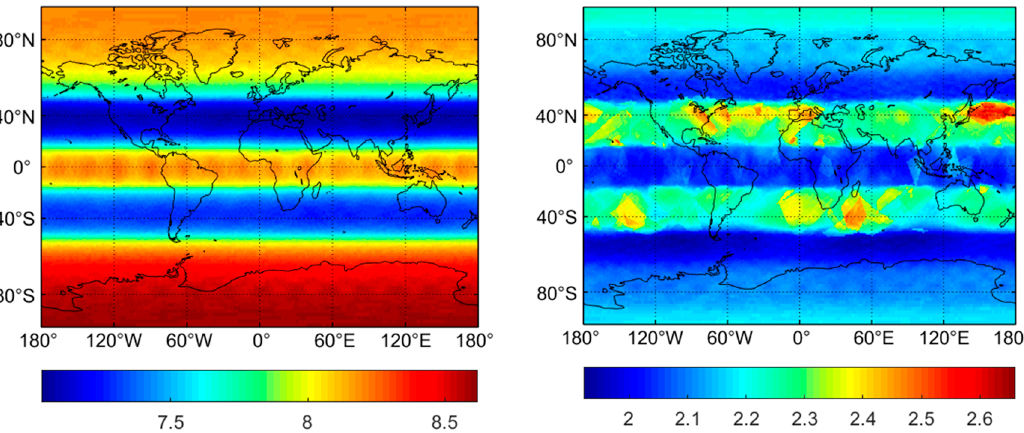
Figure 1. The satellite number and PDOP of a single Galileo at a 10° cut-off elevation